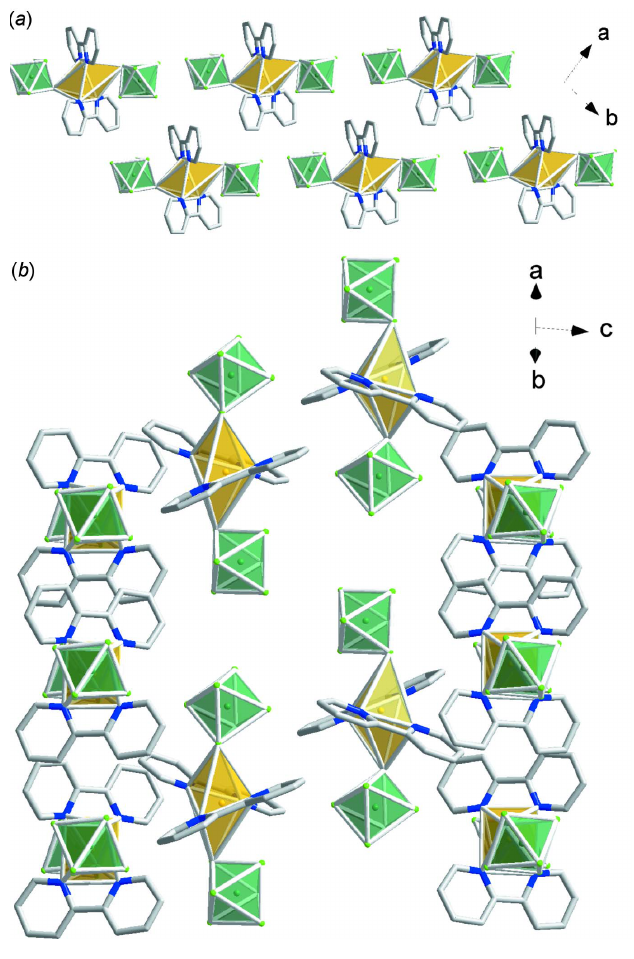
Figure 6 Packing diagram for (II): yellow polyhedra represent Cu(bpy) 22+ cations and green polyhedra represent TaF 6 (cid:3)